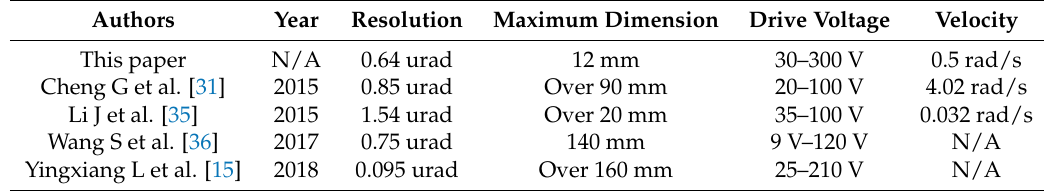
Table 1. Comparison of the rotary piezoelectric